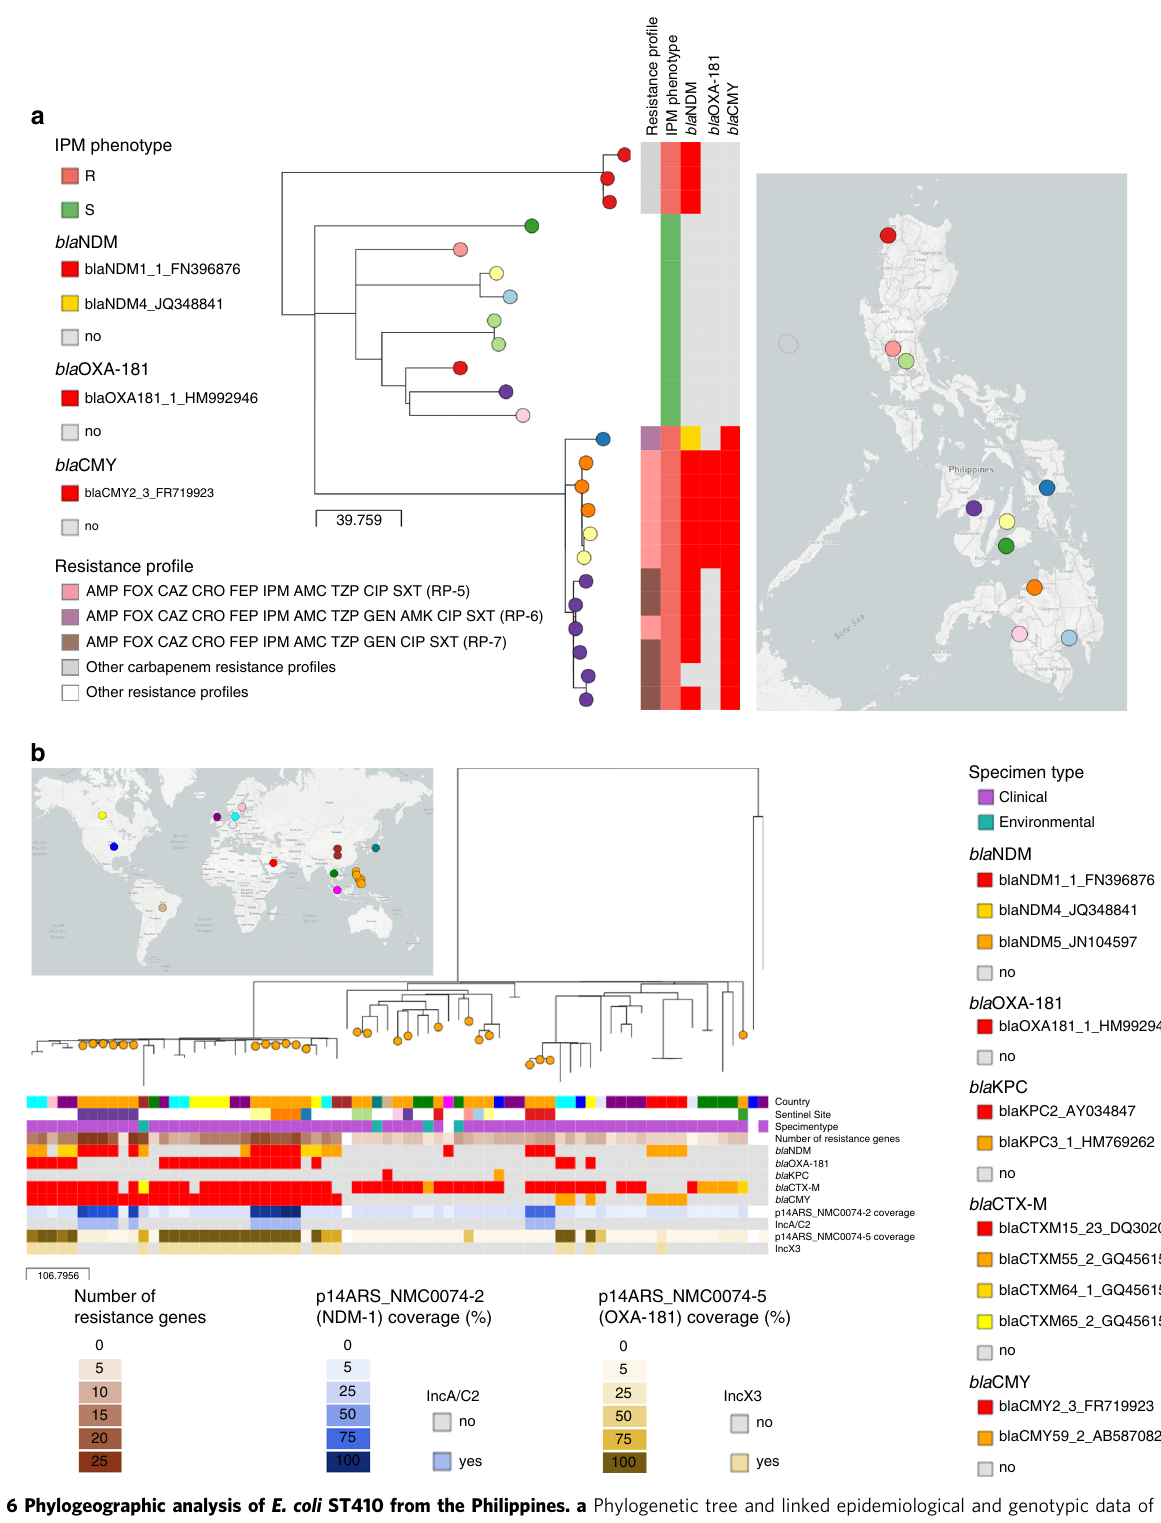
Fig. 6 Phylogeographic analysis of E. coli ST410 from the Philippines. a Phylogenetic tree and linked epidemiological and genotypic data of 24 retrospective ST410 genomes. The imipenem (IPM) phenotype was either resistant (R) or susceptible (S). The three-letter antibiotic codes in the resistance pro fi les are as in Table 1. This interactive view is available at https://microreact.org/project/ARSP_ECO_ST410/088ba65b. b Philippine isolates (orange nodes) in global context. This interactive view is available at https://microreact.org/project/ARSP_ECO_ST410_GLOBAL/c701506e. The maximum-likelihood trees were inferred from 703 (A) and 2851 (B) SNP positions, respectively, identi fi ed by mapping the genomes to reference AMA1167 (CP024801.1) and masking regions corresponding to mobile genetic elements and recombination. The scale bars show the number of SNPs per variable site. The distribution of plasmids with carbapenemases genes in ( b ) was inferred by mapping the short reads of the genomes to the complete plasmid sequences, and a match was counted when the reads covered at least 95% of the sequence length with at least 5× depth of coverage. The full data are available at https://microreact.org/project/ARSP_ECO_ST410 ( a ) and https://microreact.org/project/ARSP_ECO_ST410_GLOBAL ( b